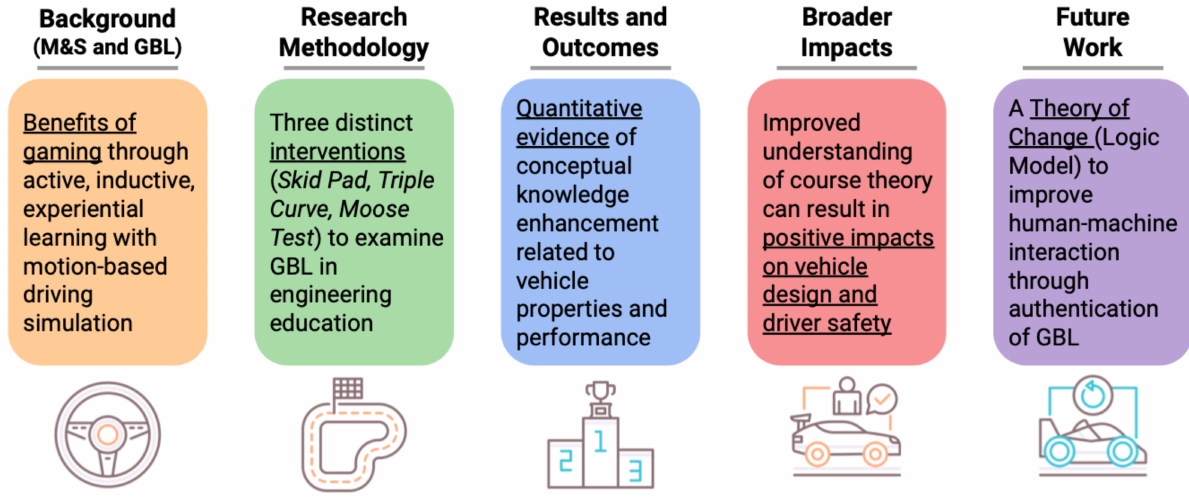
Figure 1. Overall workflow of current